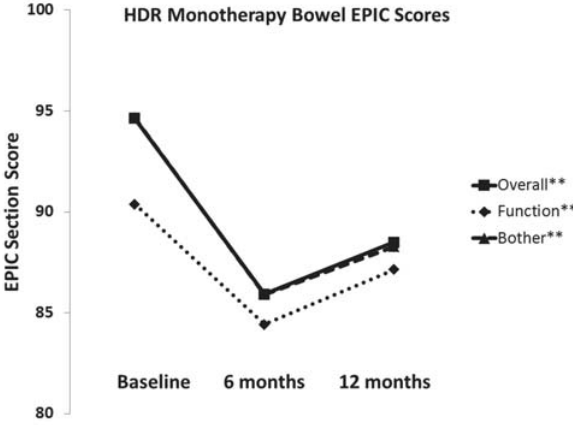
Figure 2 - EPIC bowel overall, function, and bother scores before HDR brachytherapy monotherapy and 6 and 12 months after treatment.